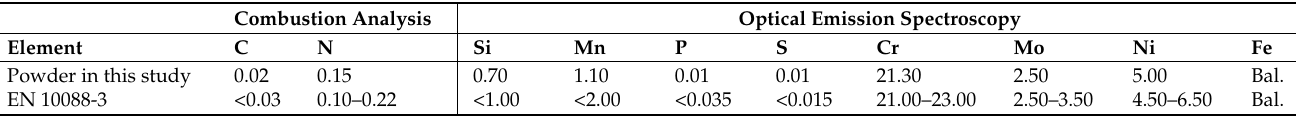
Table 1. Chemical composition of AISI 318LN powder and the corresponding material standard in